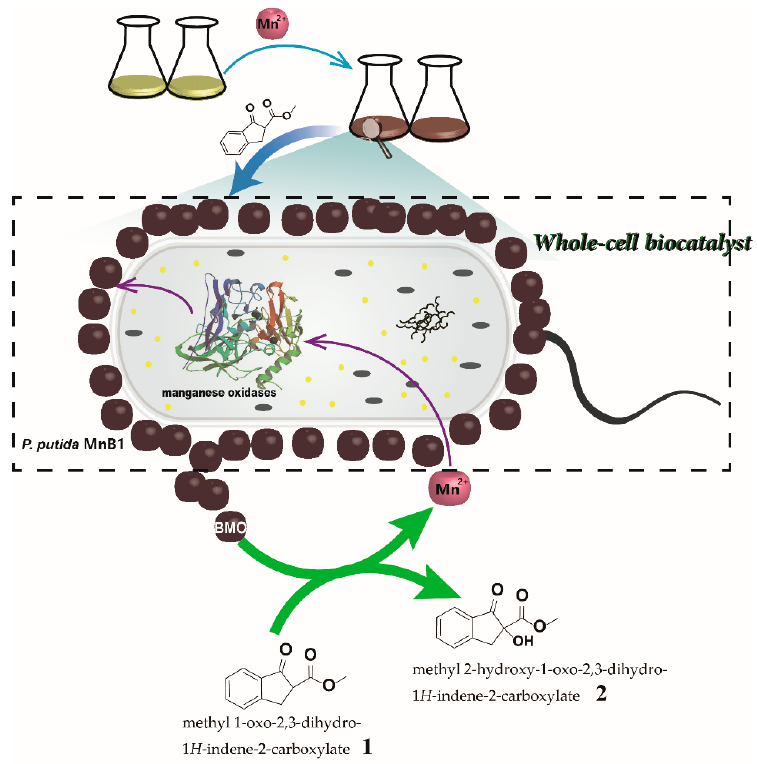
Figure 1. α -hydroxy- β -keto ester ( 1 ) by whole-cell biocatalysis based on biogenic manganese oxides Figure 1. α‐ hydroxy ‐β‐ keto ester ( 1 ) by whole ‐ cell biocatalysis based on biogenic manganese oxides (BMO)